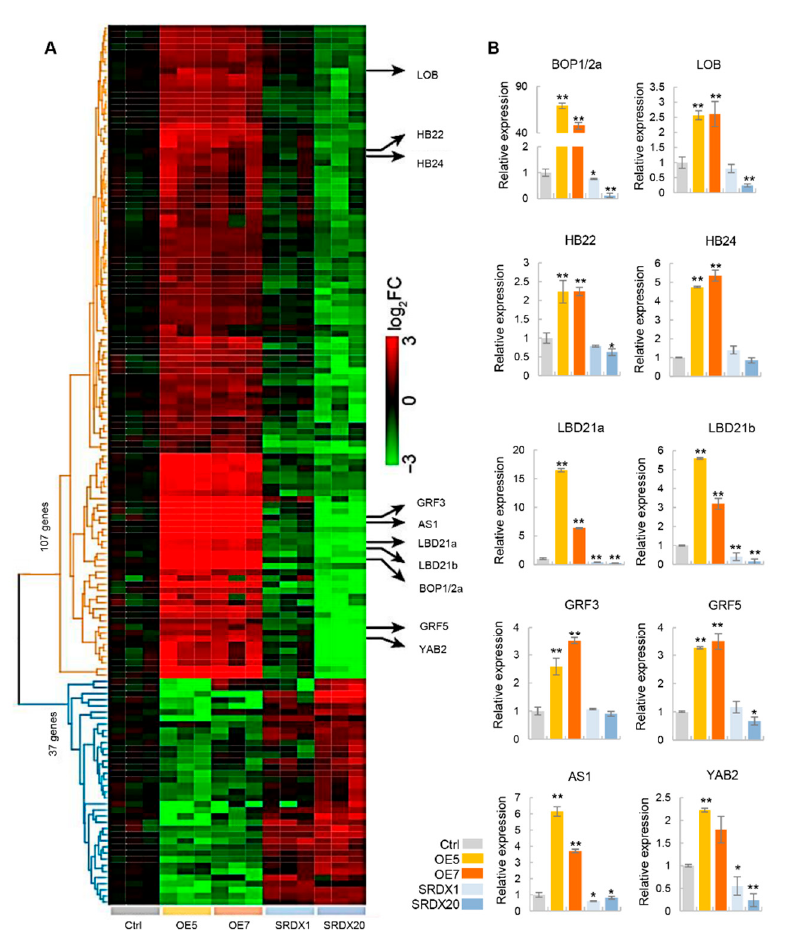
Figure 4. The analysis of changes in gene expression in leaves in PagKNAT2/6b transgenic lines. ( A ) Heatmap of common differentially expressed genes (common-DEGs) in control plants (Ctrl) and PagKNAT2/6b transgenic lines. A total of 107 genes were up-regulated in OE5 or OE7 and down- regulated in SRDX1 or SRDX20, and 37 genes were down-regulated in OE and up-regulated in SRDX lines. The ten key-DEGs related to leaf development are marked on the right. ( B ) qRT-PCR validation of the relative expression of the key-DEGs. Asterisks denote significant differences compared to Ctrl, * p < 0.05 or ** p <